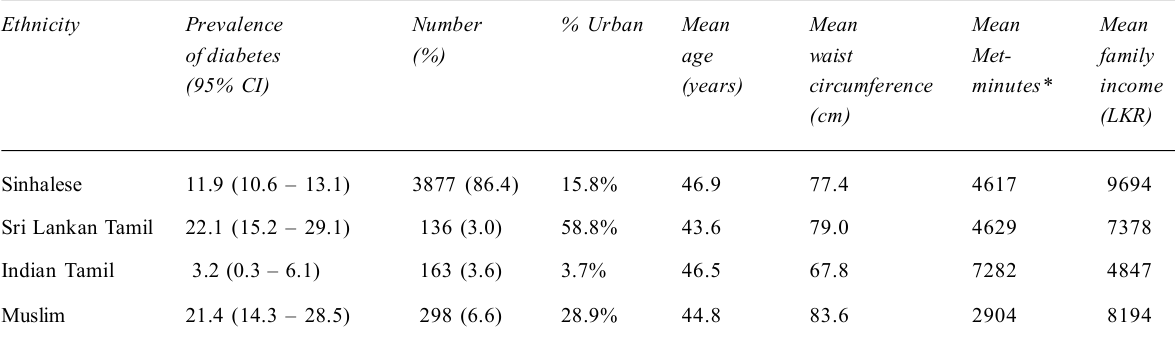
Table 2. Ethnic specific prevalence of diabetes, underlying risk factors and socio-demographic correlates